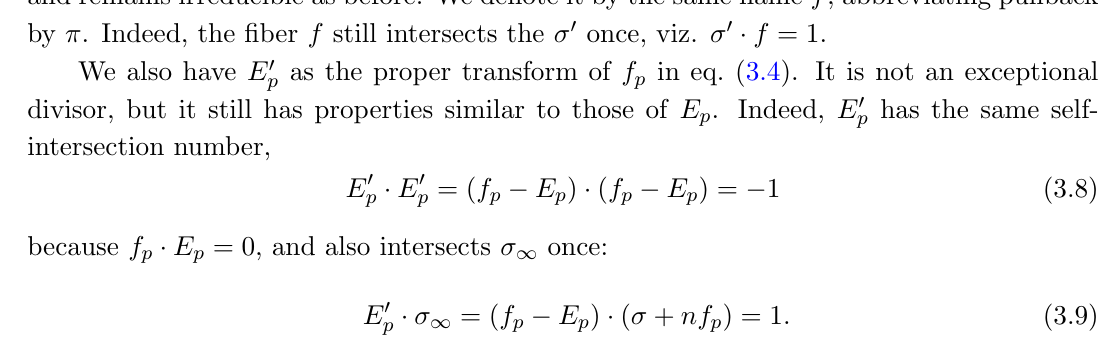
Careful analysis of the Weierstrass equation, as given in the appendix A, shows that E not a discriminant locus but locally support the type II Kodaira (cid:12)ber. Therefore, there is no gauge theory supported at the 7-brane on E